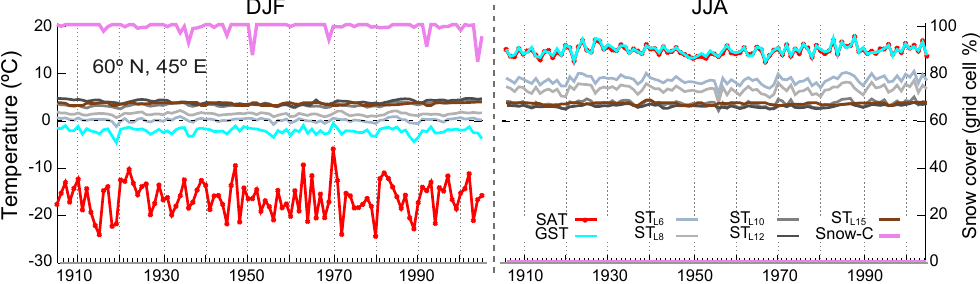
Figure 3. Evolution of DJF and JJA SAT, GST, ST L6 , ST L8 , ST L10 , ST L12 and ST L15 and the percentage of snow cover during the 1900– 2005CE period for a grid point from the ALL- F 2 simulation (northeast of Russia; 60 ◦ N, 45 ◦ E) where snow cover is characteristic during the cold season. Dashed lines indicate 0 ◦